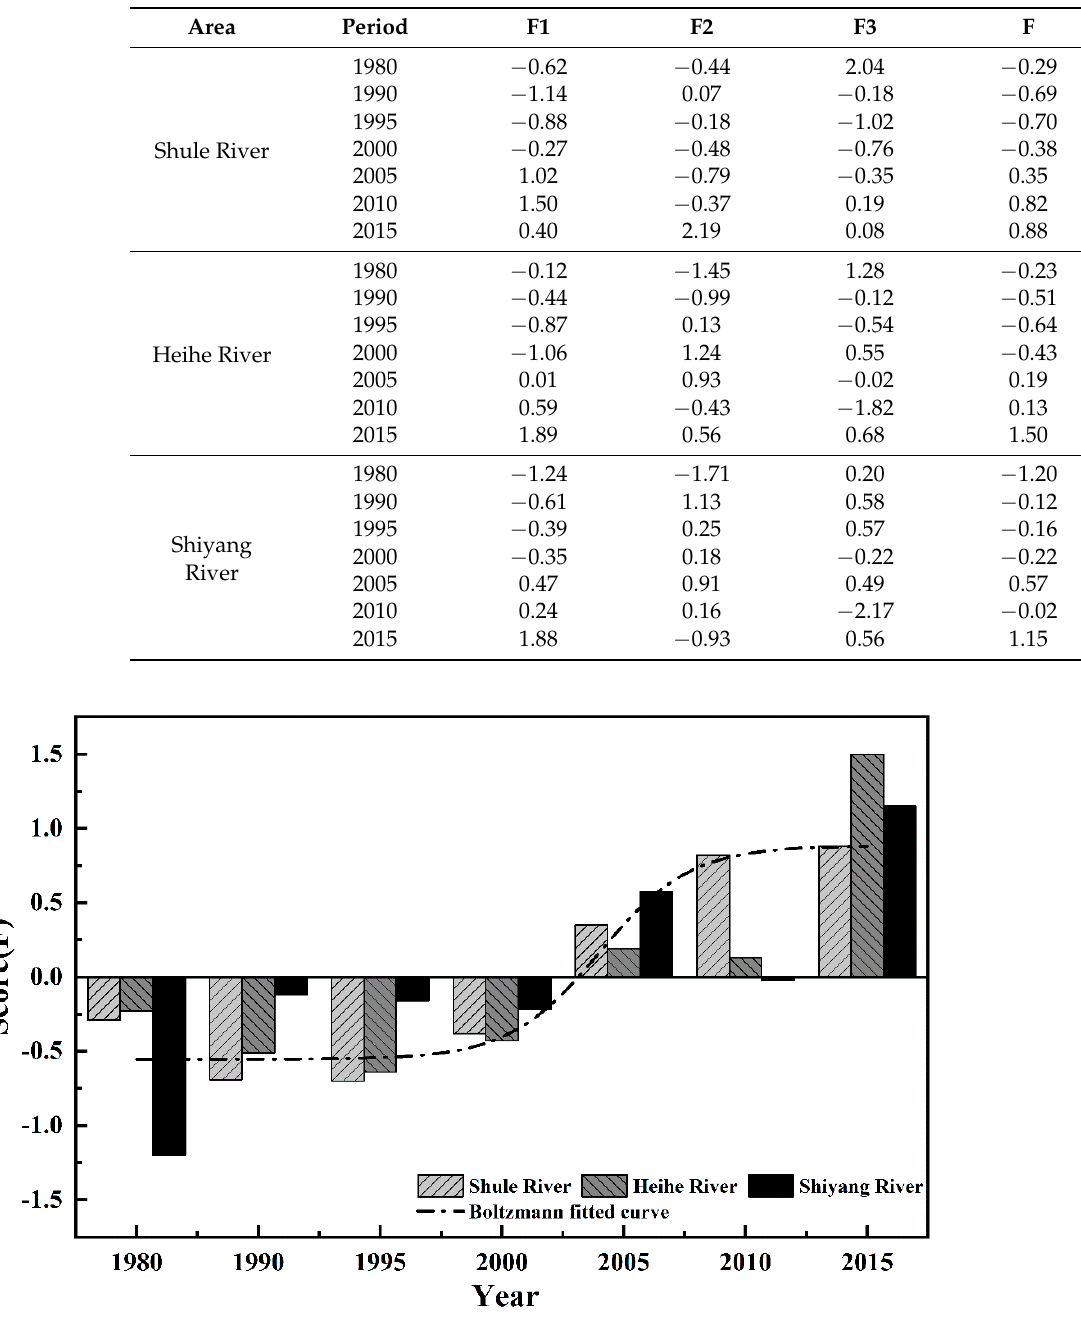
Table 6. Score coefficient of the principal component factors and the score of the comprehensive driving force in each period.